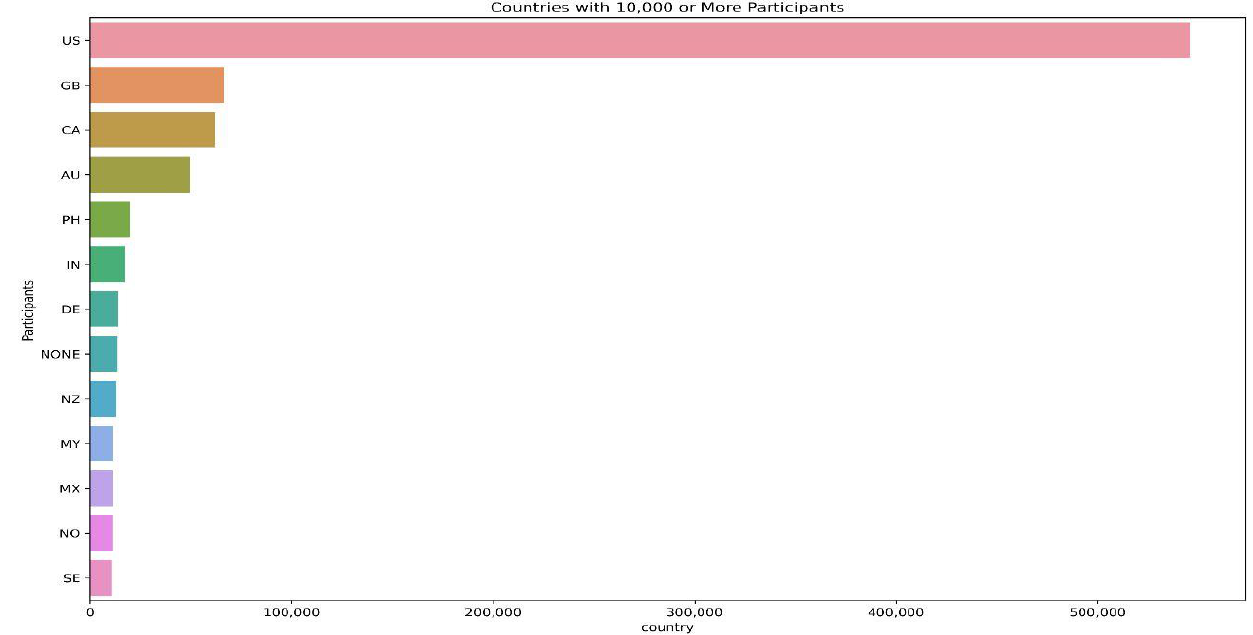
Figure 3. The distribution of participants on the dataset.